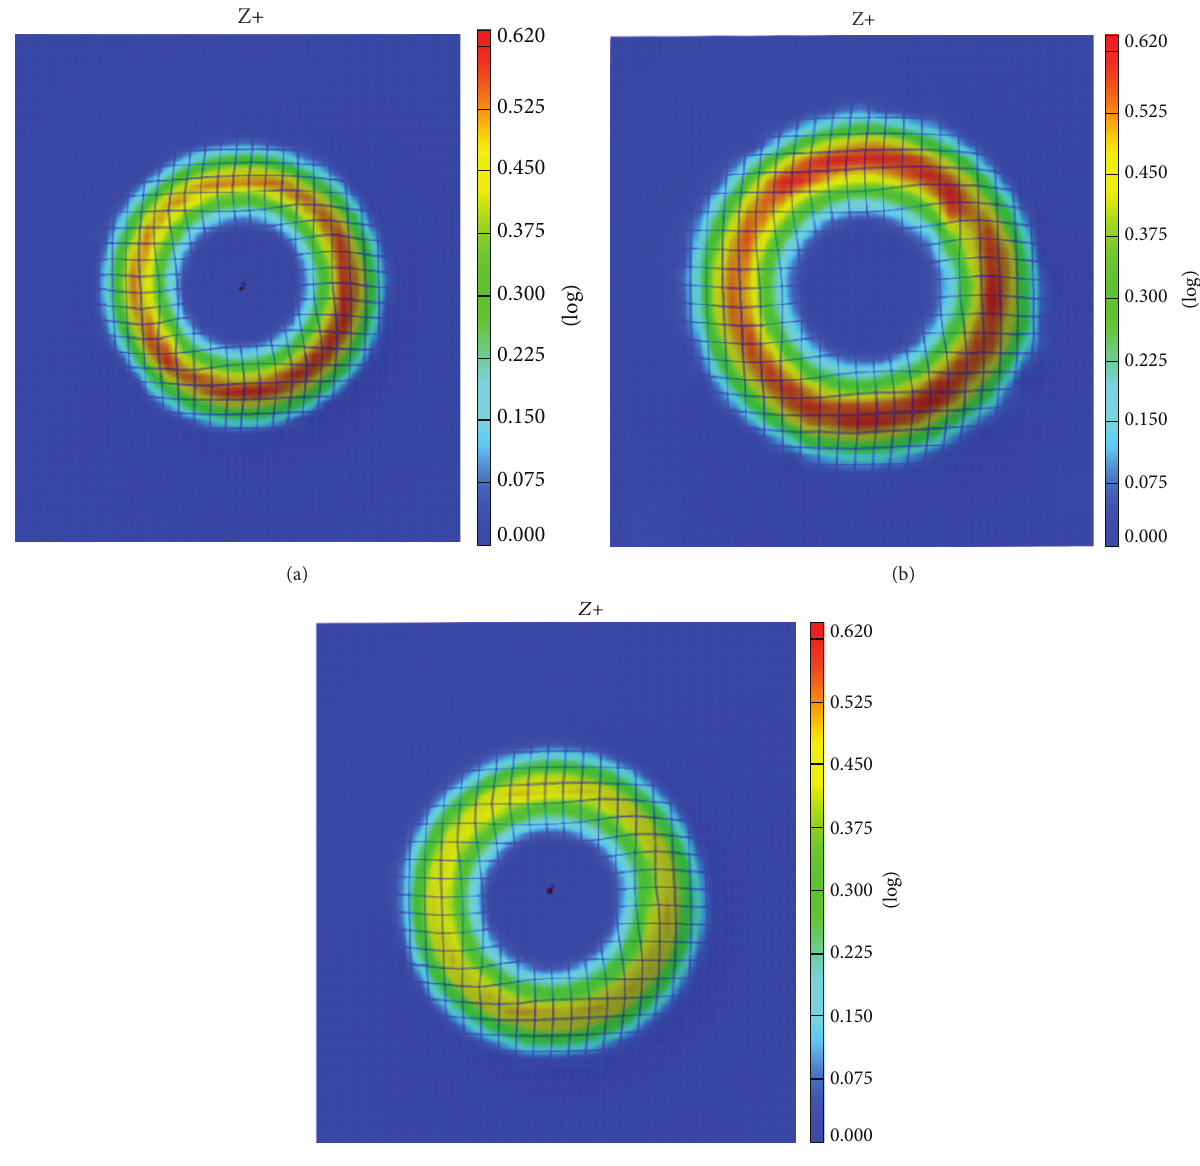
Figure 4: The major strain variation for the specified three different